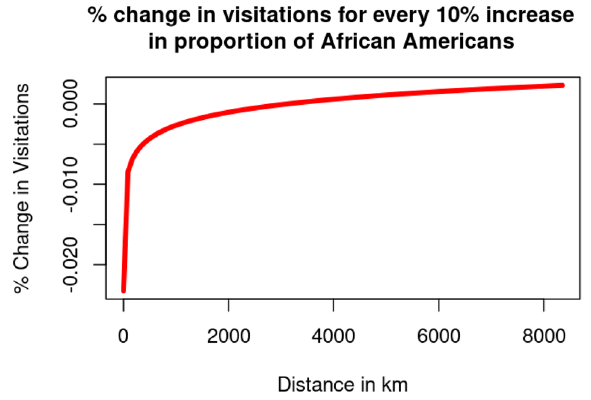
Figure 4. Changes visitation to each national park for every 10% increase of the proportion of African